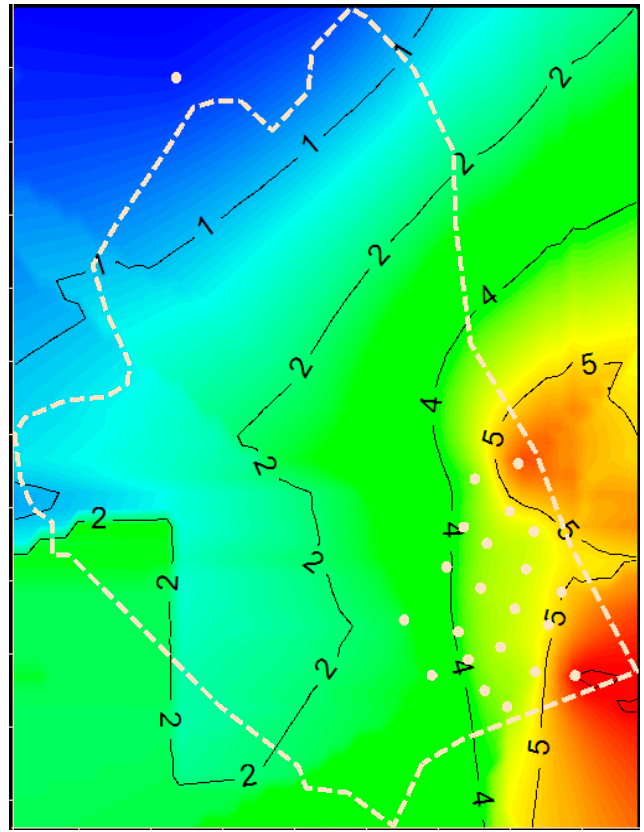
Figure 3. Groundwater contours in meter Australian Height Datum (AHD) (Year 1991; pre-construction). Water level data points shown as grey dots (circle); Dashed line represents model area and grey is bedrock.